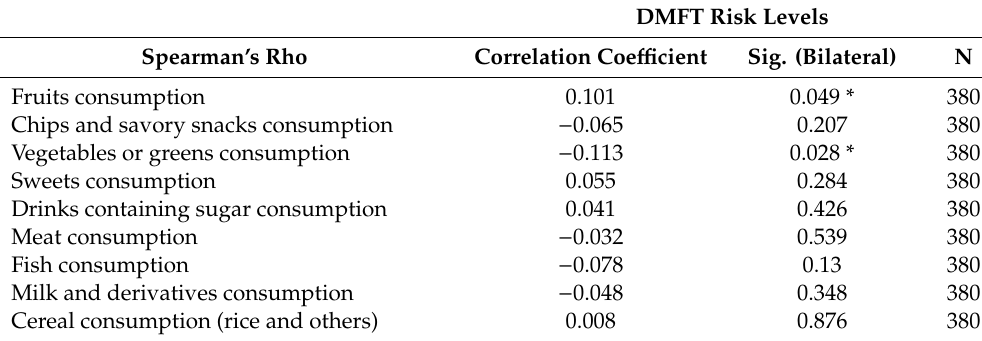
Table 3. DMFT risk levels and eating habits